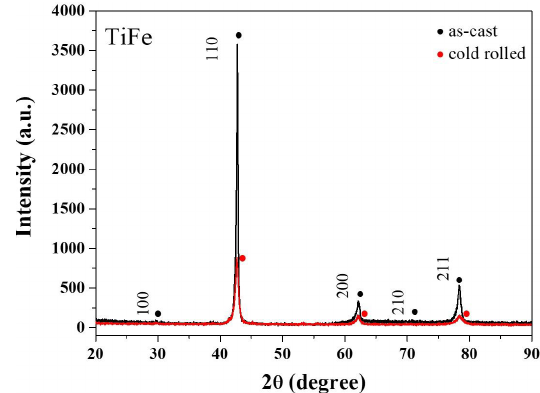
Figure 1. XRD spectra of the TiFe IMC alloy in the as-cast and cold-rolled